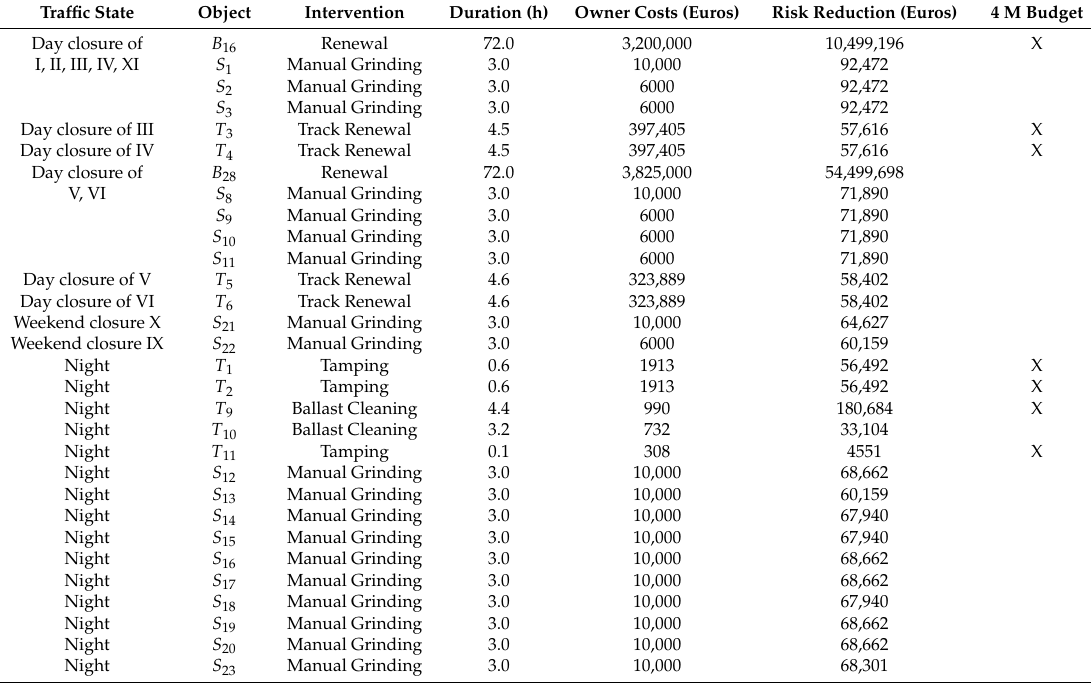
Table 8. Optimal intervention program determined using the network flow model.